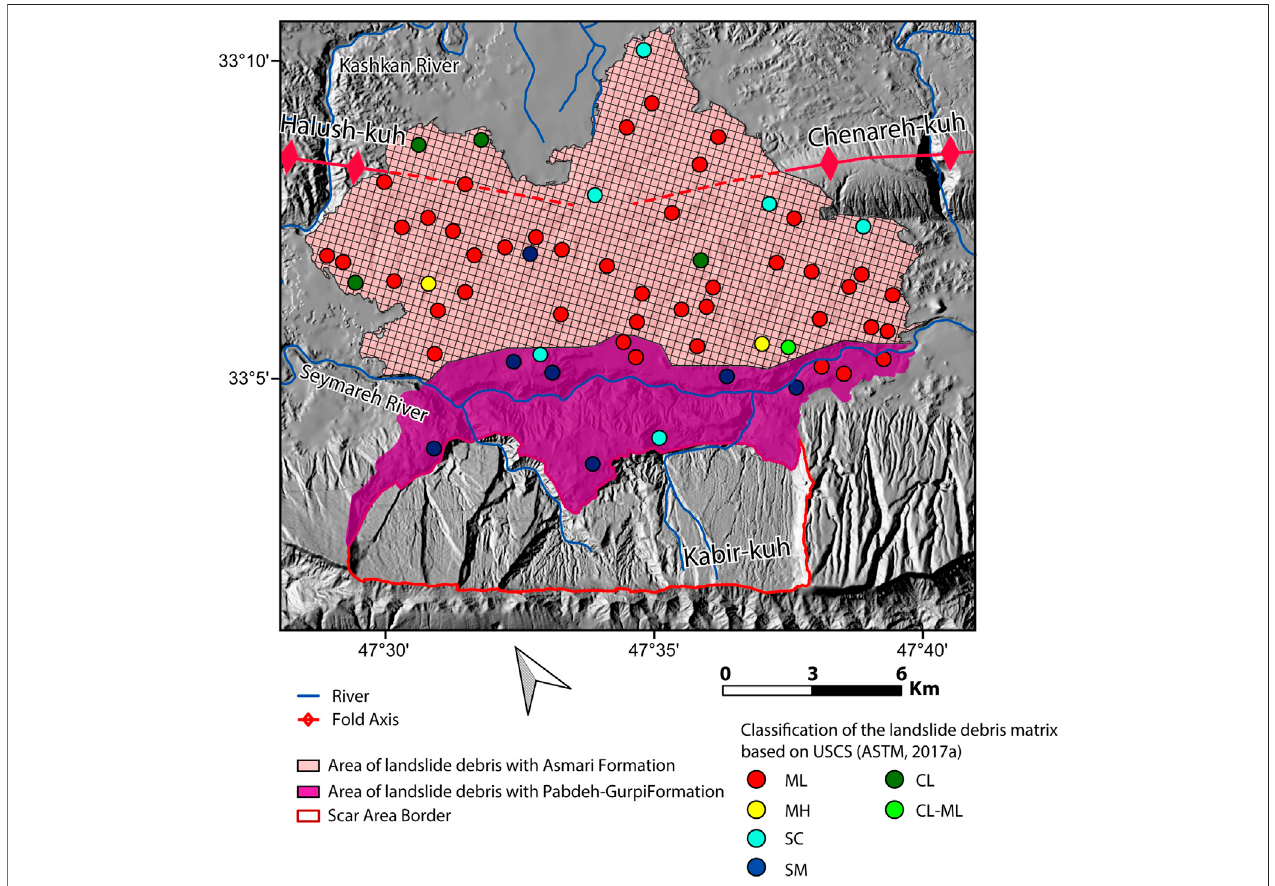
FIGURE 5 | Locations of the 62 USCS classi fi ed samples on the Seymareh landslide debris. The areas of the landslide debris with Asmari Formation and with Pabdeh – Gurpi Formation are shown according to Roberts and Evans (2013). The coordinate reference system is